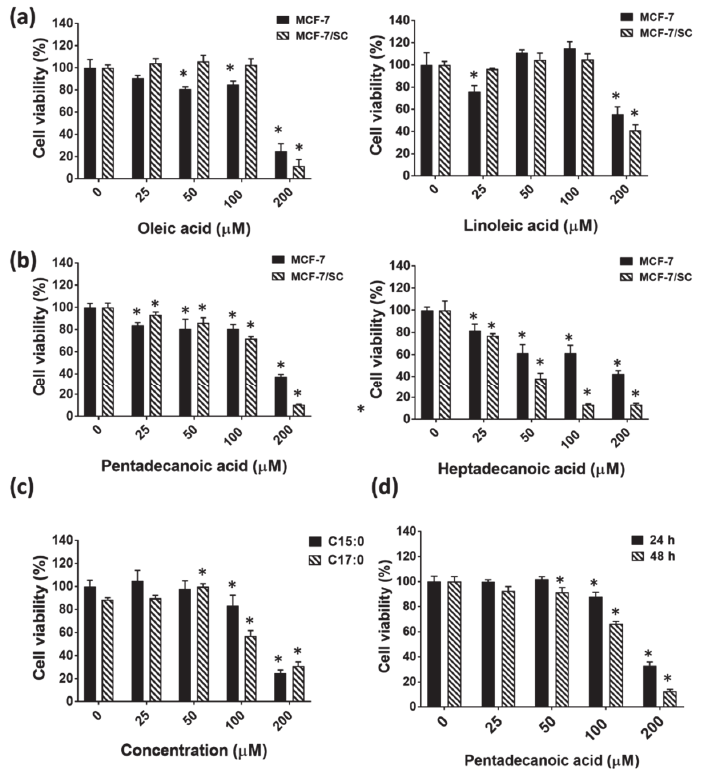
Figure 2. Pentadecanoic acid exerts cytotoxicity in MCF-7 / SC and MCF-7 cells. Comparison of cytotoxic e ff ects in MCF-7 / SC and MCF-7 cells following 48 h of incubation. ( a ) Unsaturated fatty acids: oleic acid (C18:1) and linoleic acid (C18:2). ( b ) Odd-chain fatty acids: pentadecanoic acid (C15:0) and heptadecanoic acid (C17:0). ( c ) E ff ects of pentadecanoic acid and heptadecanoic acid on MCF-10A cell proliferation after 48 h of incubation. ( d ) Time-dependent (24 and 48 h) cytotoxic e ff ects of pentadecanoic acid in MCF-7 / SC. Data are shown as the mean ± standard deviation of three biologically independent experiments. * p < 0.05 vs.